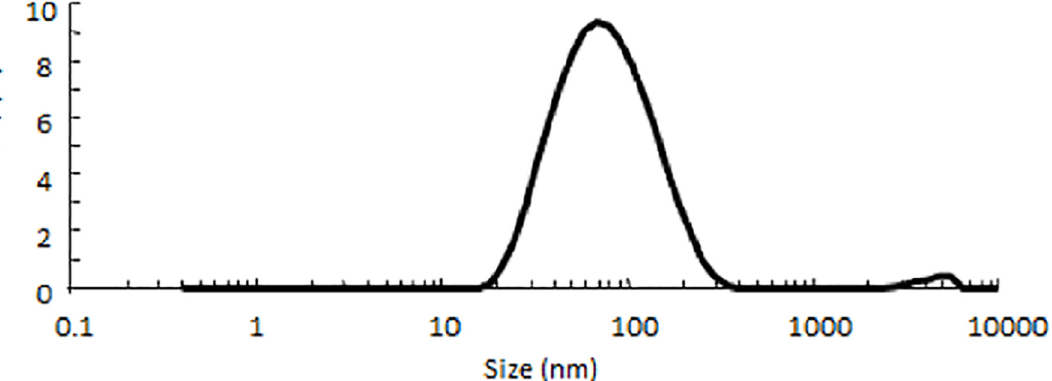
Fig 1. Size Distribution of Curcumin/Liposome. Representative data on the size of curcumin/liposome are shown here. The vertical axis shows the relative intensity of light scattering and the horizontal axis shows the size of liposomes on log scale.